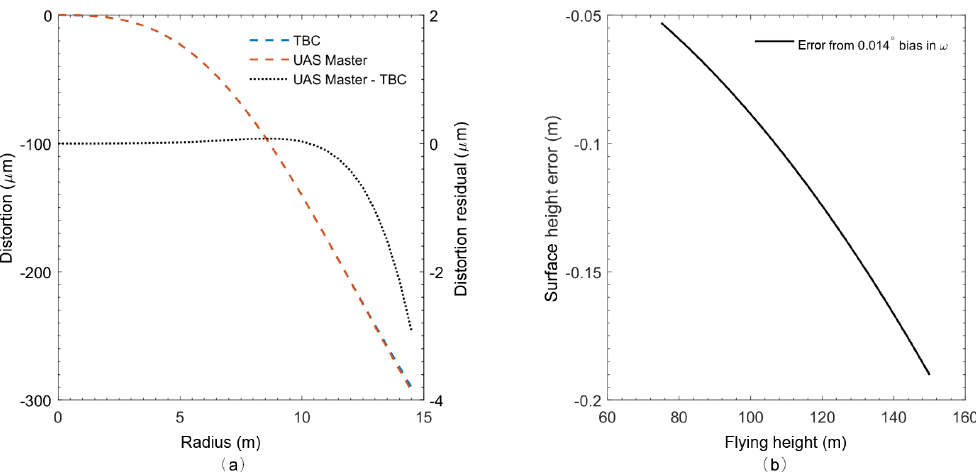
Figure 11. Comparison of lens distortion characterised by individual triangulations of data from the same flight carried out in two different software packages, TBC and UAS Master (a) , and the error in surface height propagated by a bias in the roll parameter, ω , in relation to flying height (b) . The distortion residual was only apparent at radial distances > 12mm (a) , while the observed mean bias in ω that was propagated by TBC results in substantial errors in surface height (b)